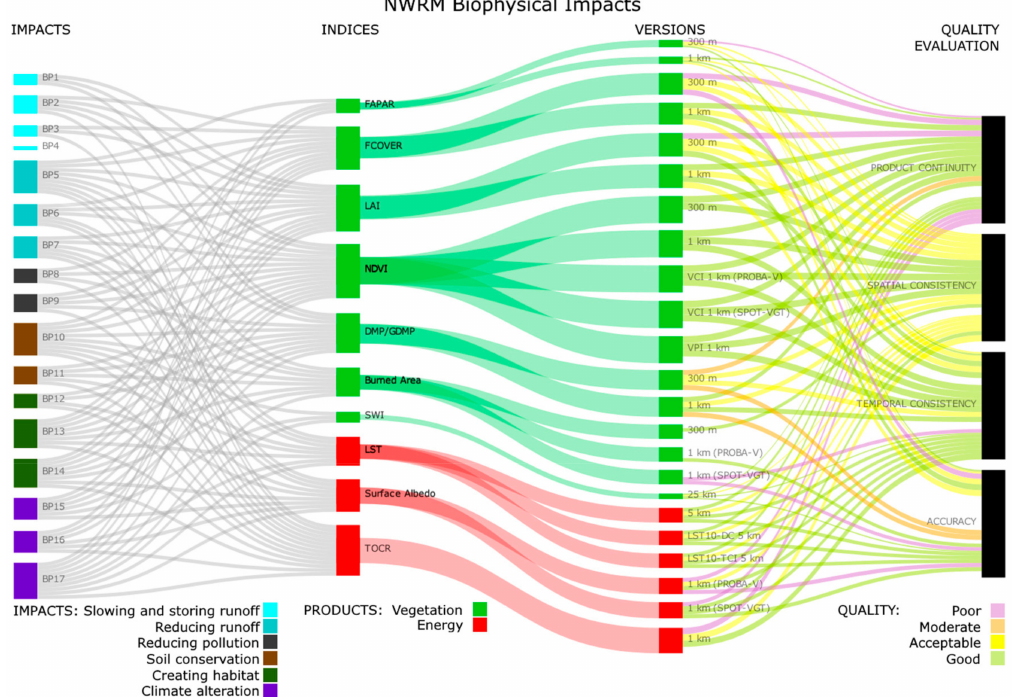
Figure A4. Sankey diagram linking the vegetation and energy indices that according to previous experiences are suitable for monitoring the biophysical impacts (BP) resulting from the application of natural water retention measures